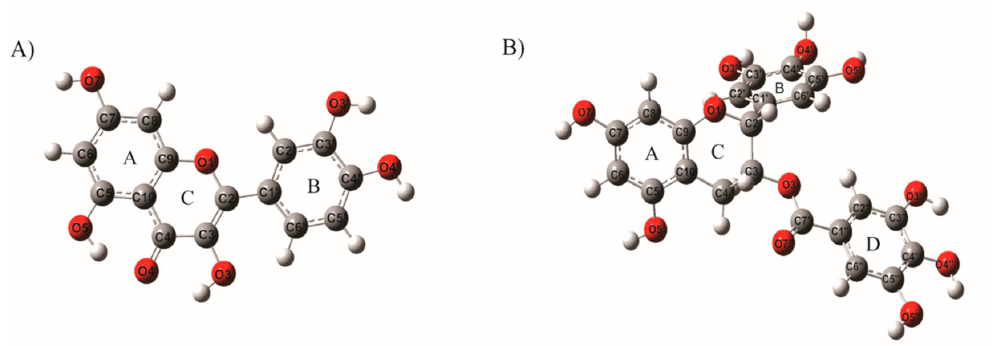
Figure 1. Optimized molecular structures of ( A ) quercetin (Q) and ( B ) epigallocatechin gallate (EGCG) calculated with the best methodology B3LYP/6-31G (d,p) in the solvent phase.